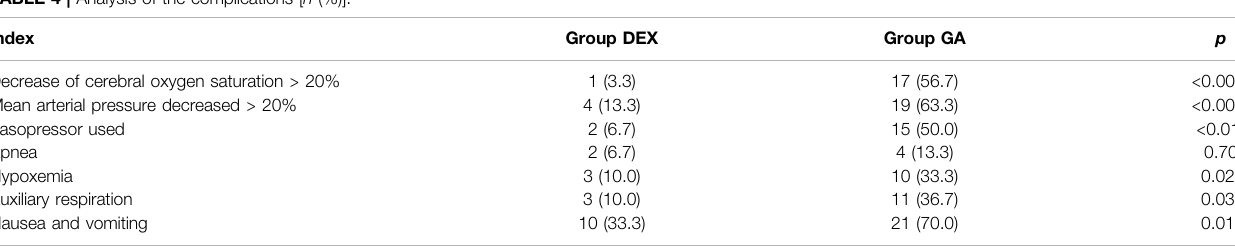
TABLE 4 | Analysis of the complications [ n